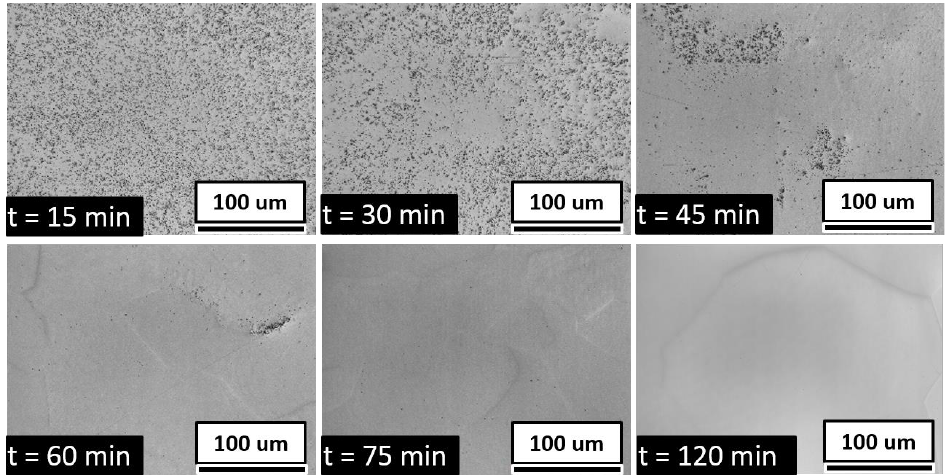
Figure 9. Laser confocal images of Nb surface during Step 2 for different processing duration. Note: imagining depicts the pollution removal, grain appearance, and grain growth.